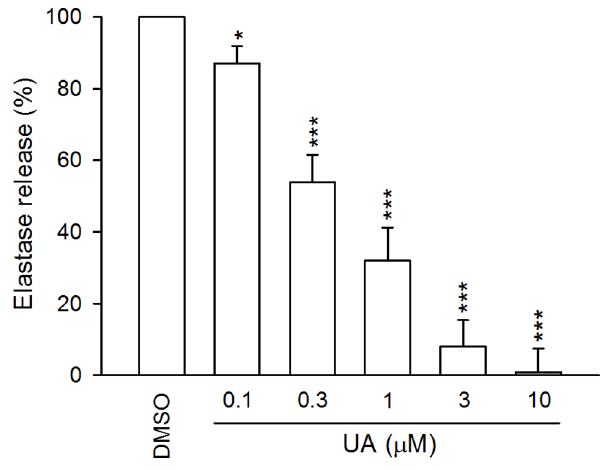
Figure 2. Effects of ursolic acid (UA) on elastase release in N- formyl-methionyl-leucyl-phenylalanine (FMLP) in the pre-prim- ing with cytochalasin B (FMLP/CB)-activated human neutro- phils. Data are shown as mean 6 SEM (n=4). * p , 0.05, ** p , 0.01, *** p , 0.001 compared to the control.